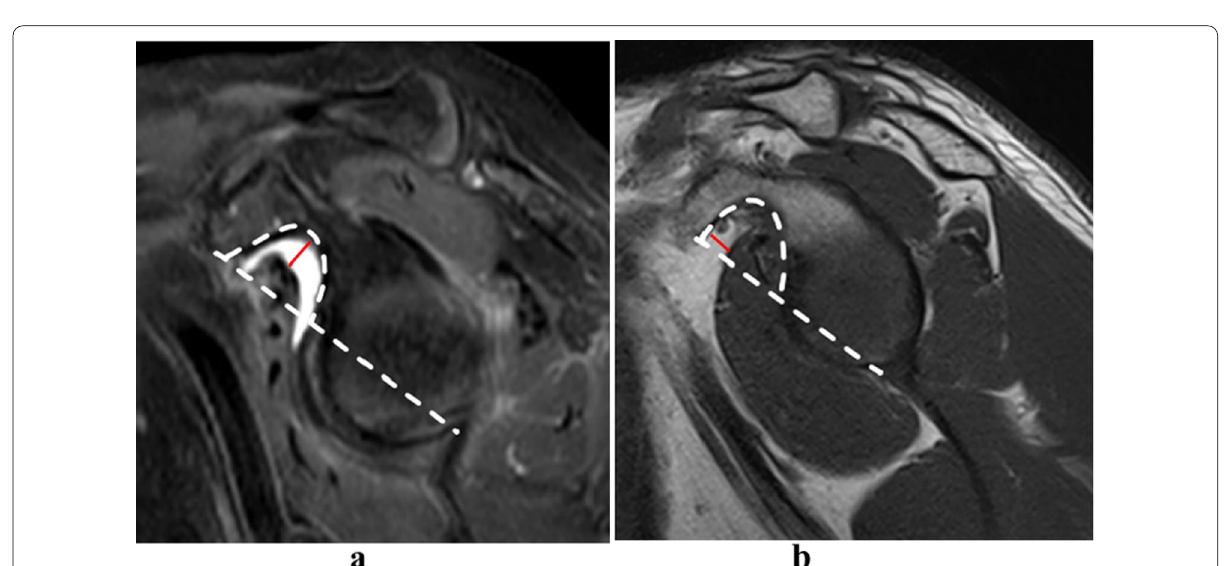
Fig. 4 Quantitative measurements of fluid collection and fat accumulation on IM-WI/fs ( a ) and T1-WI ( b ) oblique sagittal MRI at the “coraco-glenoid arch” (CGA) slice. Both the coracoid process and glenoid are well seen and connected by the base of coracoid process on this slice. An arch line can be drawn along the inferior margin of the coracoid and glenoid, another reference line is made connecting the anterior inferior coracoid tip and the leading edge of the insertion of the triceps tendon, and the maximum distance of the fluid or fat accumulated in the coraco-glenoid arch is separately